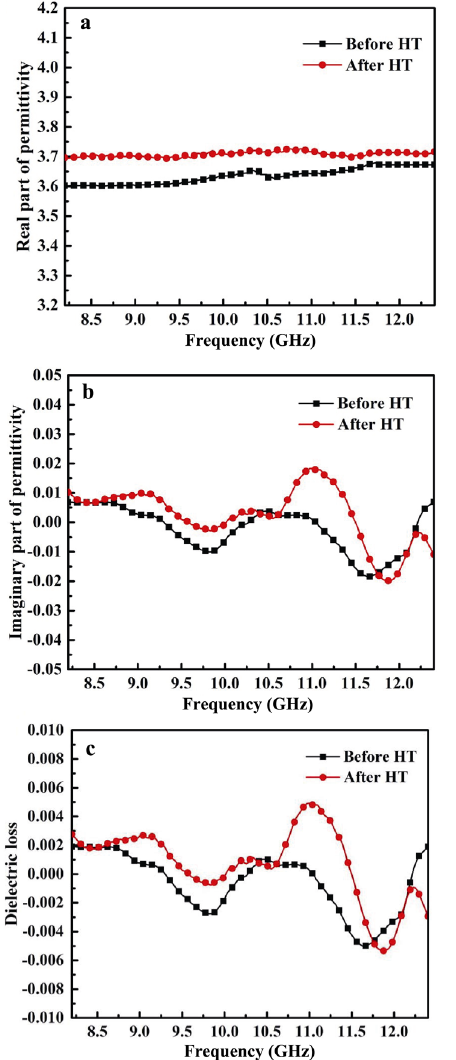
Weight, density, porosity, and flexural